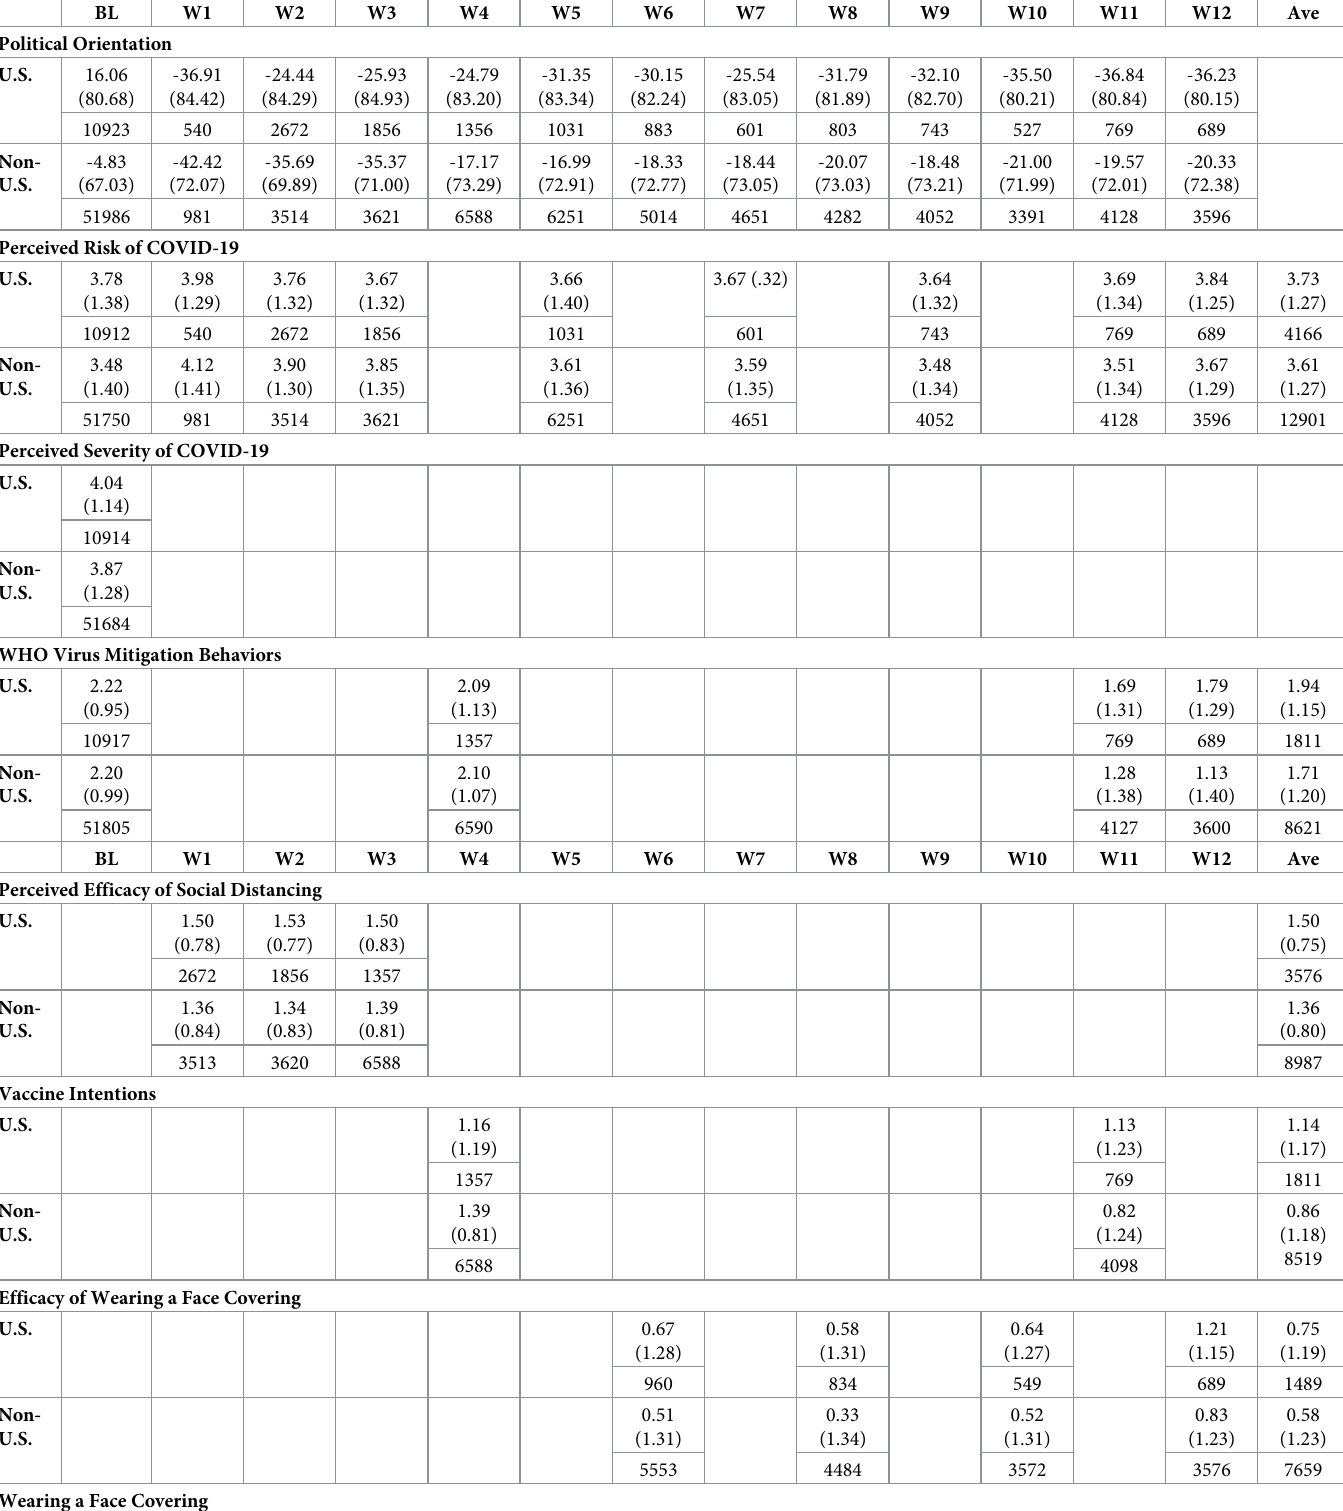
Table 4. Dates, participants, and descriptive statistics of variables used in analyses, Study 2. BL Ave Political Orientation U.S.